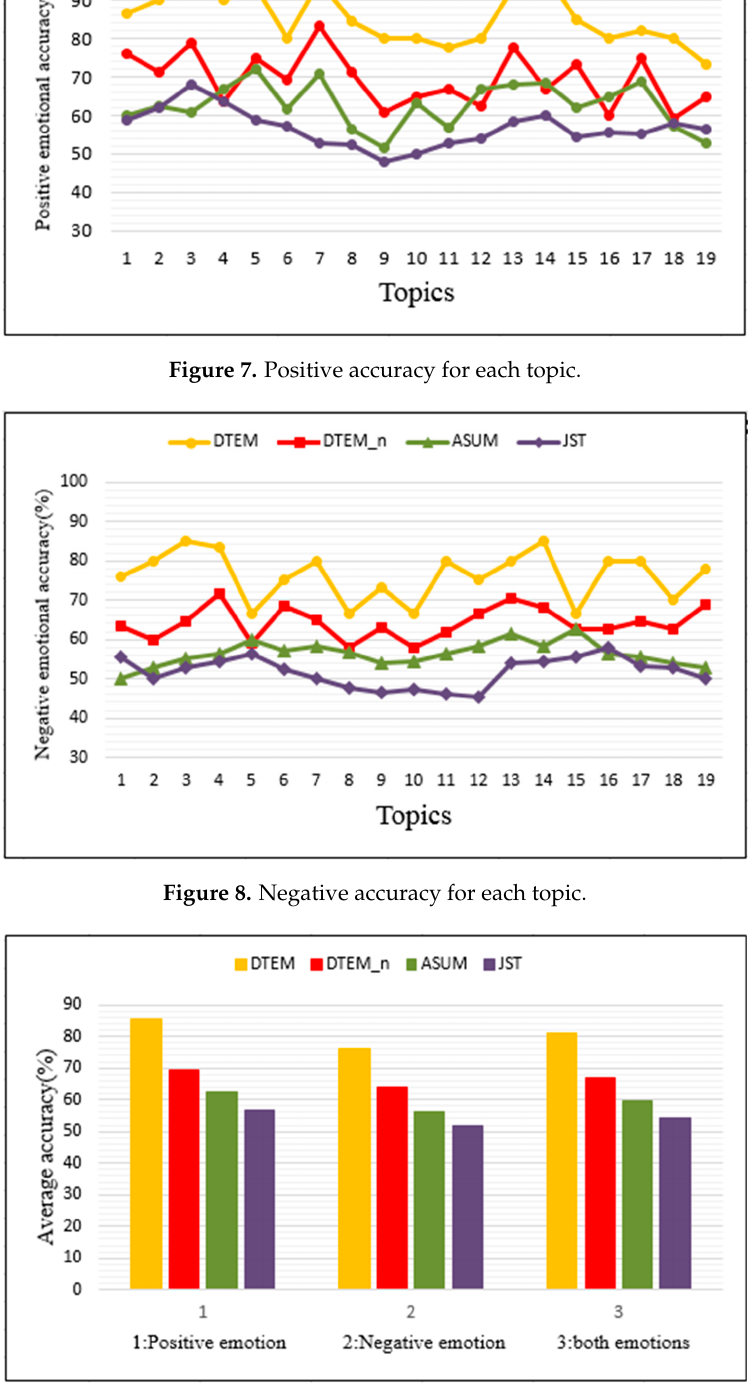
Figure 9. Average emotional accuracy of the four methods.